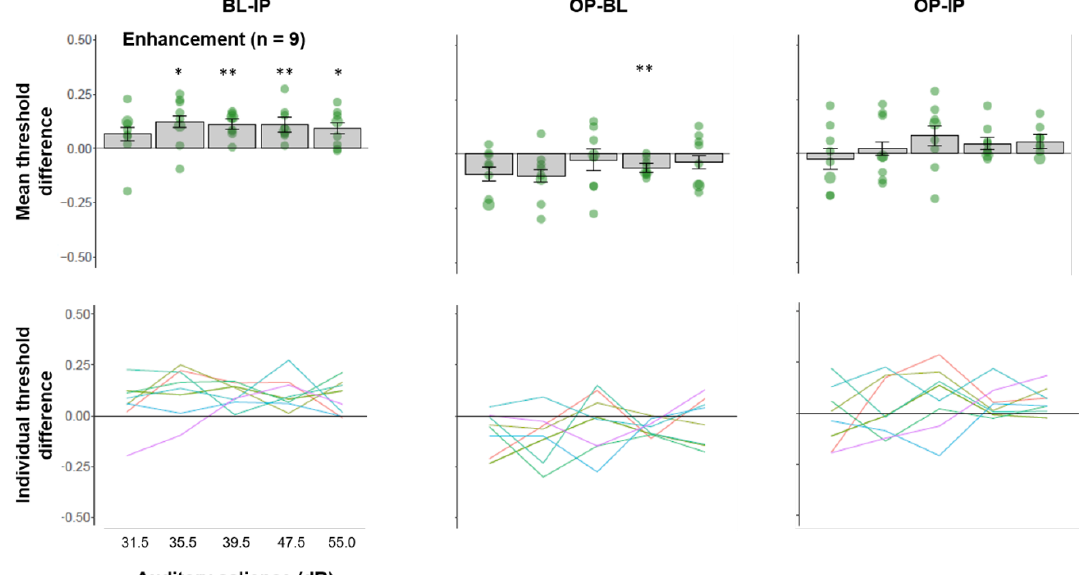
Figure 4. (Top panel) Mean threshold difference (+/- SE) and (bottom panel) trends line for individual participants across three comparisons from the facilitation group. **: p < 0.01, *: p < 0.05.